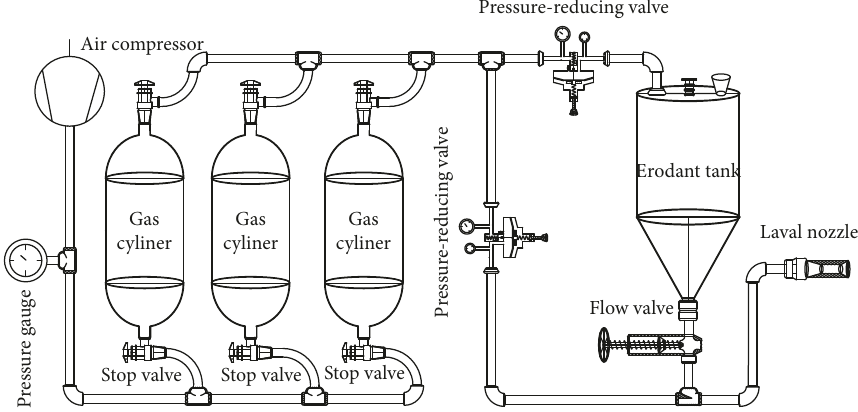
Figure 1: Schematic of connections in the high-pressure gas jet erosion